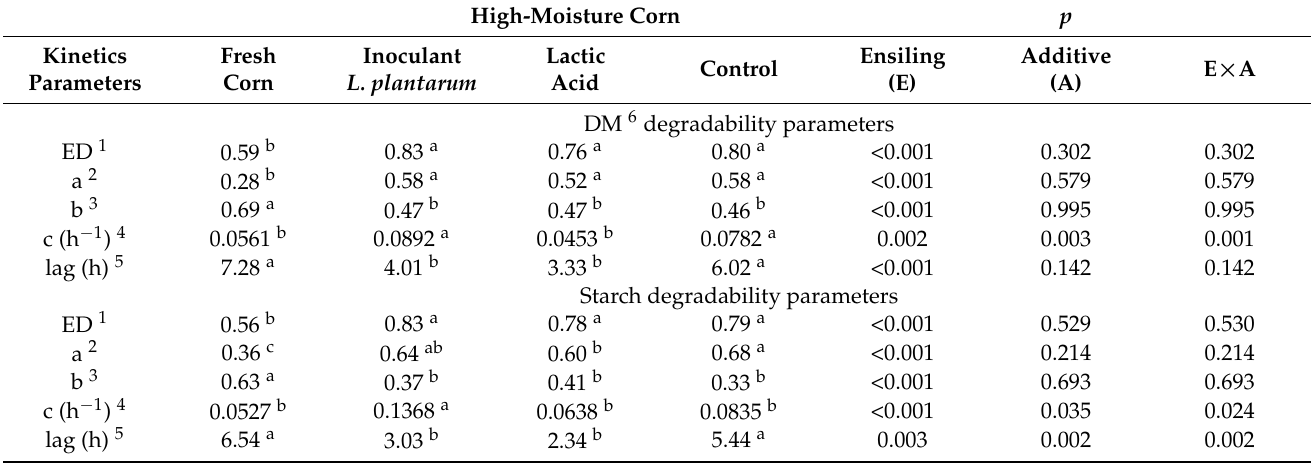
Table 1. Effects of ensiling and ensiling additives on in vitro dry matter (DM) and starch degradability